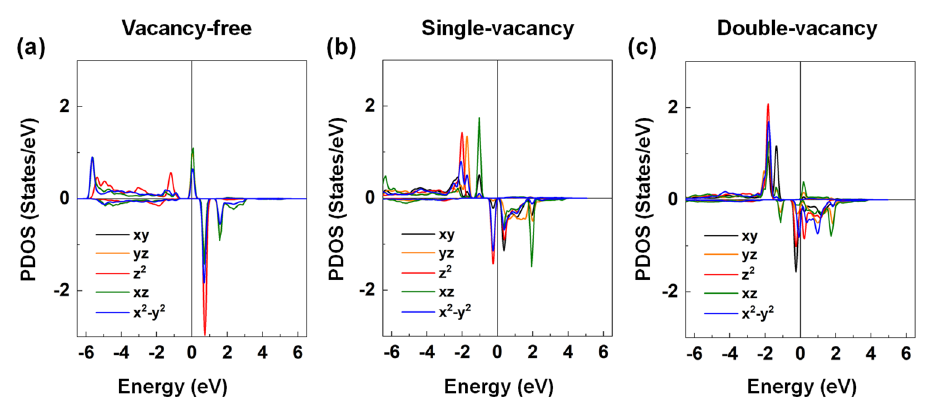
Figure 14. The DFT results of the d -orbital decomposed PDOS of the Fe substitutional atom for the BNT(Fe) with the (a) vacancy-free, (b) single-vacancy, and (c) double-vacancy. The black, orange, red, green, and blue lines represent the d xy , d yz , d z2 , d xz , and d x2 –y2 orbital states, respectively. The Fermi level is set to zero